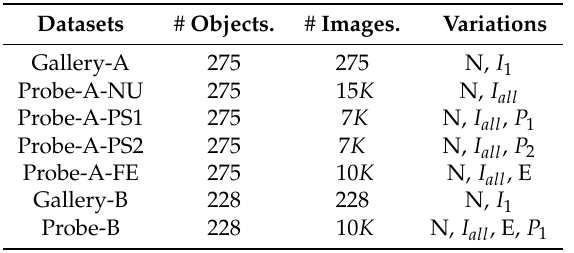
Table 5. The standard protocol of low-quality depth-based FR for different scenarios on the Extended-Multi-Dim database. The scales of objects and images and the variations in each part are also shown, where N, I, P, E indicate neutral and frontal, illumination, pose and expression. Notice, I 1 is natural light and I all contains the all illumination variations shown in Table 2. Datasets # Objects. # Images. Variations 275